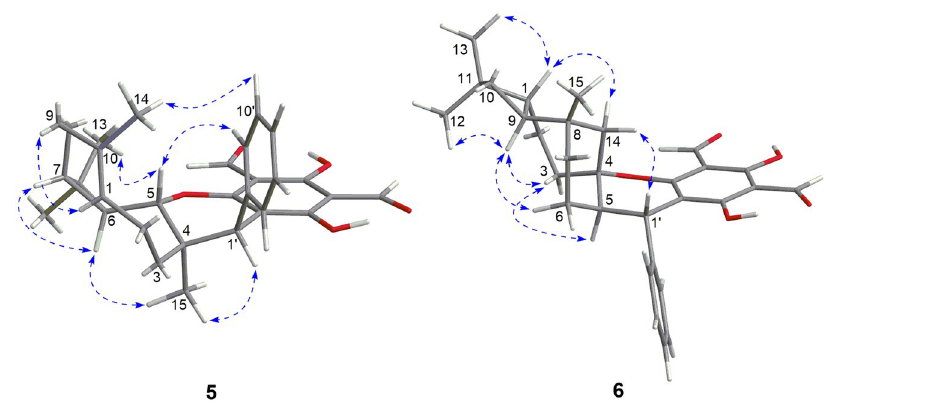
Figure 10. Selected NOESY correlations of 5 and 6